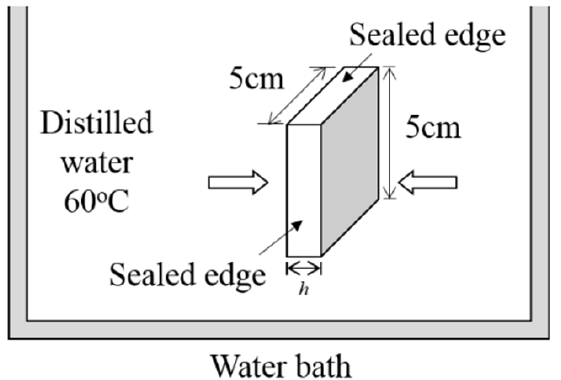
Figure 1. Figure illustrating the specimens’ configuration and moisture absorption condition.